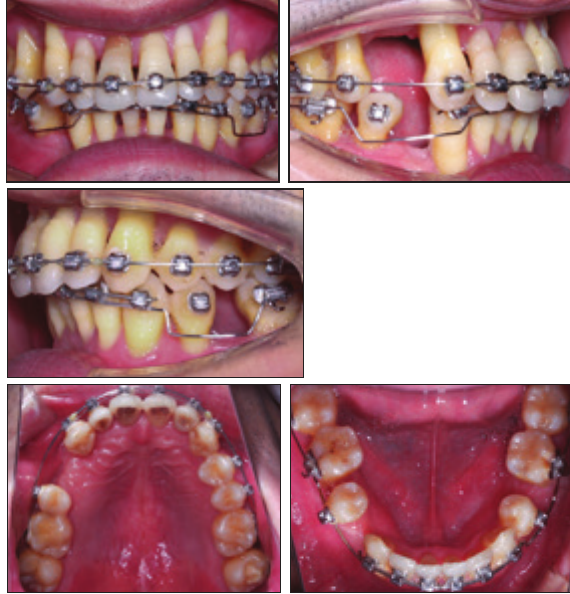
Figure 5. The application of a utility arch technique to intrude the lower incisors, made of 0.016 × 0.022 inch stainless arch wire with force of 60